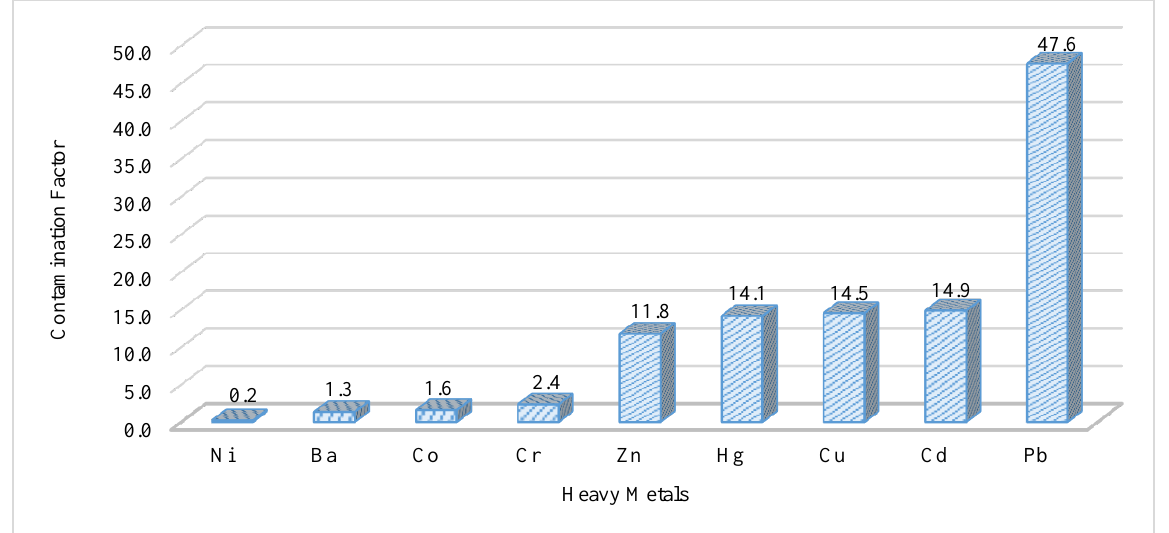
Figure 2. Contributions of respective heavy metal to the degree of